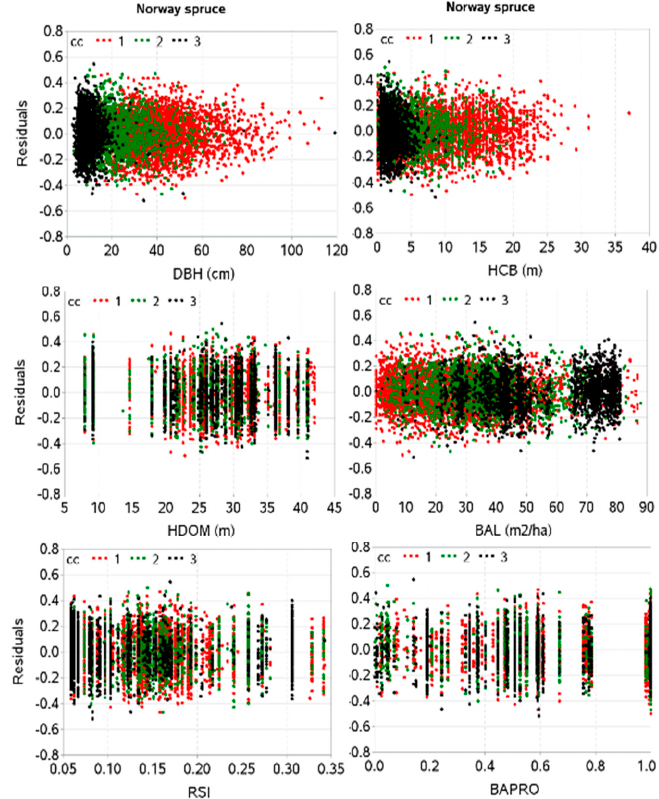
Figure 3. Standardized residuals plotted against various predictors in the CR model. Residuals versus diameter at breast height (DBH) and height to live crown base (HCB) (first panel), Residuals versus dominant height (HDOM) and basal area of larger trees in diameter than a subject tree (BAL) (second panel), Residuals versus relative spacing index (RSI) and basal area proportion of a species (BAPRO) (third panel). CC = canopy height class 1: height greater than 66% of the tallest tree, 2: height between 33% and 66% of the tallest tree, and 3: height less than 33% of the tallest tree.